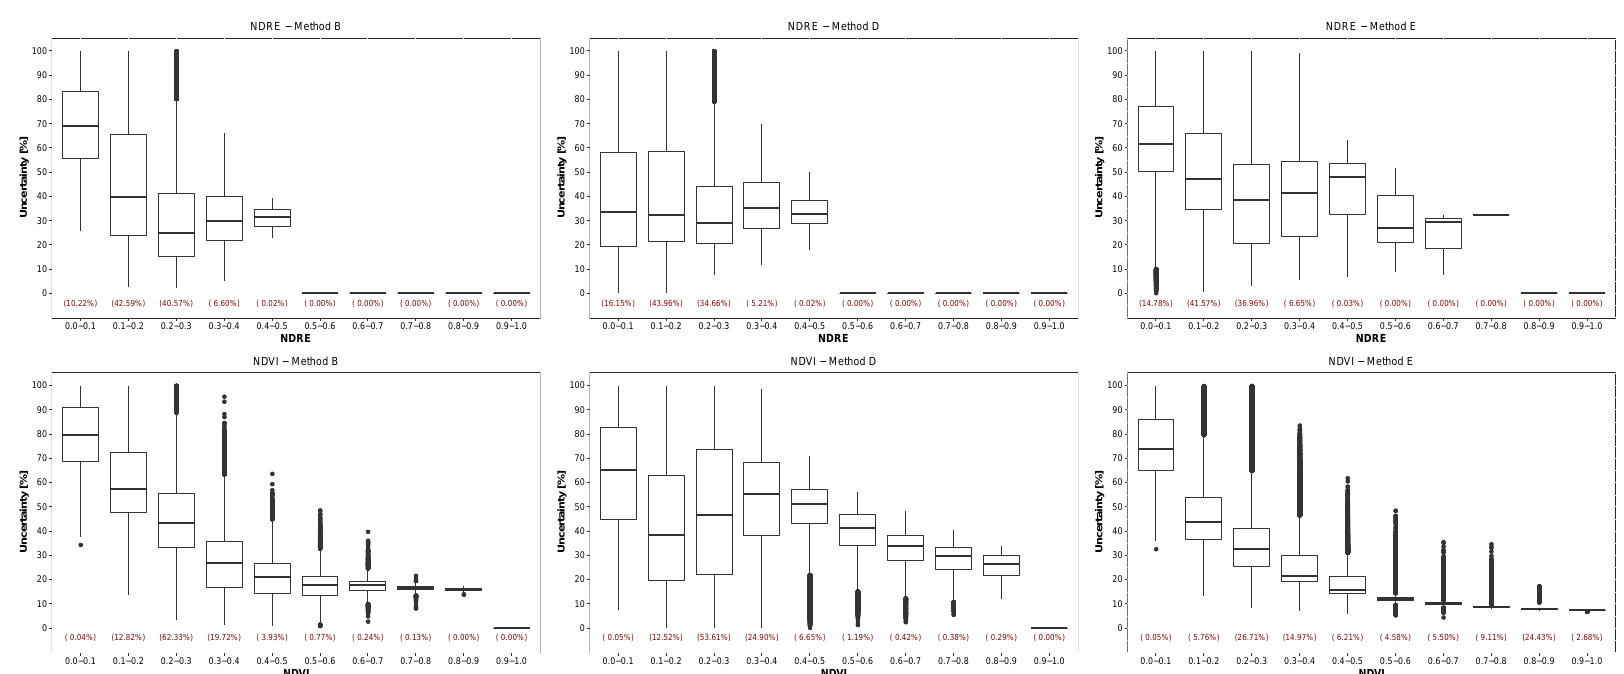
Figure 11. Uncertainty as a function of NDVI and NDRE values for radiometric calibration methods B, D, and E. The values in parentheses indicate the percentage of pixels within the image representative of the corresponding range of values on the